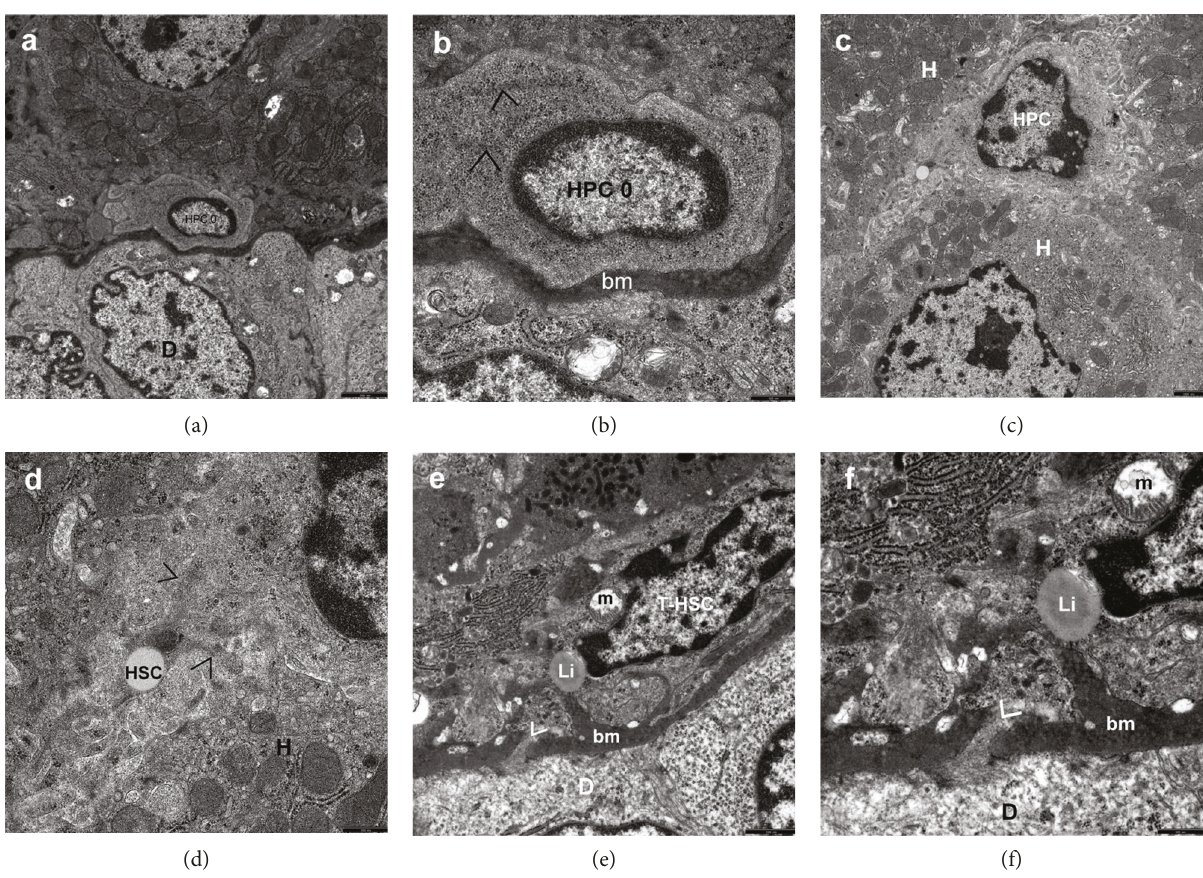
Figure 1: (a – f). Electron micrographs showing the periportal area of the hepatic lobule 1 week after inducing BDL in rats. (a) A very primitive-looking HPC — the periductular type 0 cell (HPC 0), corresponded to the so-called nondescript cell, located outside the basement membrane of the bile ductule. The HPC does not show any sign of di ff erentiation or penetration of the basement membrane. The cell is very small in size, oval in shape, has scanty cytoplasm, high nucleus/cytoplasm ratio, and undi ff erentiated cytoplasmic and surface structures. It contains an oval nucleus in which heterochromatin is seen in the nucleoplasm with peripheral condensation. D: ductular epithelial cell. Scale bar, 2.5 μ m, original magni fi cation × 4400. (b) At higher magni fi cation, the cytoplasm of the HPC 0 is seen to contain contours of single tono fi laments ( > ); the basement membrane (bm) of the bile ductule. Scale bar, 0.5 μ m, original magni fi cation × 20000. (c) The view of HPC di ff erentiating towards a bile duct-like cell, pushed in the space between hepatocytes (H) with a large number of microvilli directed towards the intercellular space. The oval cell exhibits the minimum di ff erentiated cytoplasmic structures containing numerous free ribosomes and delicate plasma membrane fi lapodia adhering to the microvilli. Scale bar, 1 μ m, original magni fi cation × 7000. (d) Higher magni fi cation well demonstrates the picture of cell interaction between HPC and the activated hepatic stellate cell (HSC) present at a very close distance. Processes ( > ) of fi ne HSC containing a single lipid droplet adhere tightly to the slightly folded cell membrane of the HPC. Scale bar, 0.5 μ m, original magni fi cation × 20000. (e) The view of elongated transitional hepatic stellate cell (T-HSC) located outside the basement membrane (bm) of the neoformed bile ductule and intimately associated with it. The T-HSC lost a considerable part of lipid material and contains only a single tiny lipid droplet (Li). On the other hand, it has an abundance of granular endoplasmic reticulum channels. The cell nucleus is elongated, and its heterochromatin is seen as clumps of a varied size dispersed in the nucleoplasm with peripheral condensation. In the vicinity of the nucleus, markedly swollen mitochondrium (m) is visible. The basement membrane extended along the biliary ductule shows a rupture ( > ), with the appearance of a process directed by the T-HSC. Scale bar, 1 μ m, original magni fi cation × 12000. (f) A higher magni fi cation clearly demonstrates basement membrane penetration by the cytoplasmic process of T-HSC, causing its focal discontinuity and formation of a direct contact ( > ) with the ductular epithelial cell (D). Scale bar, 0.5 μ m, original magni fi cation ×